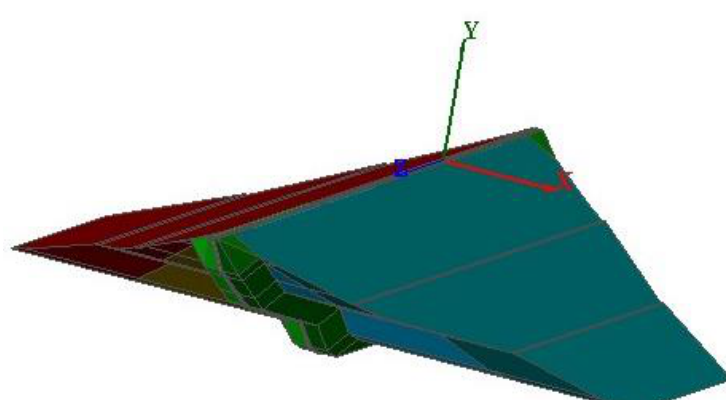
Figure 5. 3D solid model of dam.